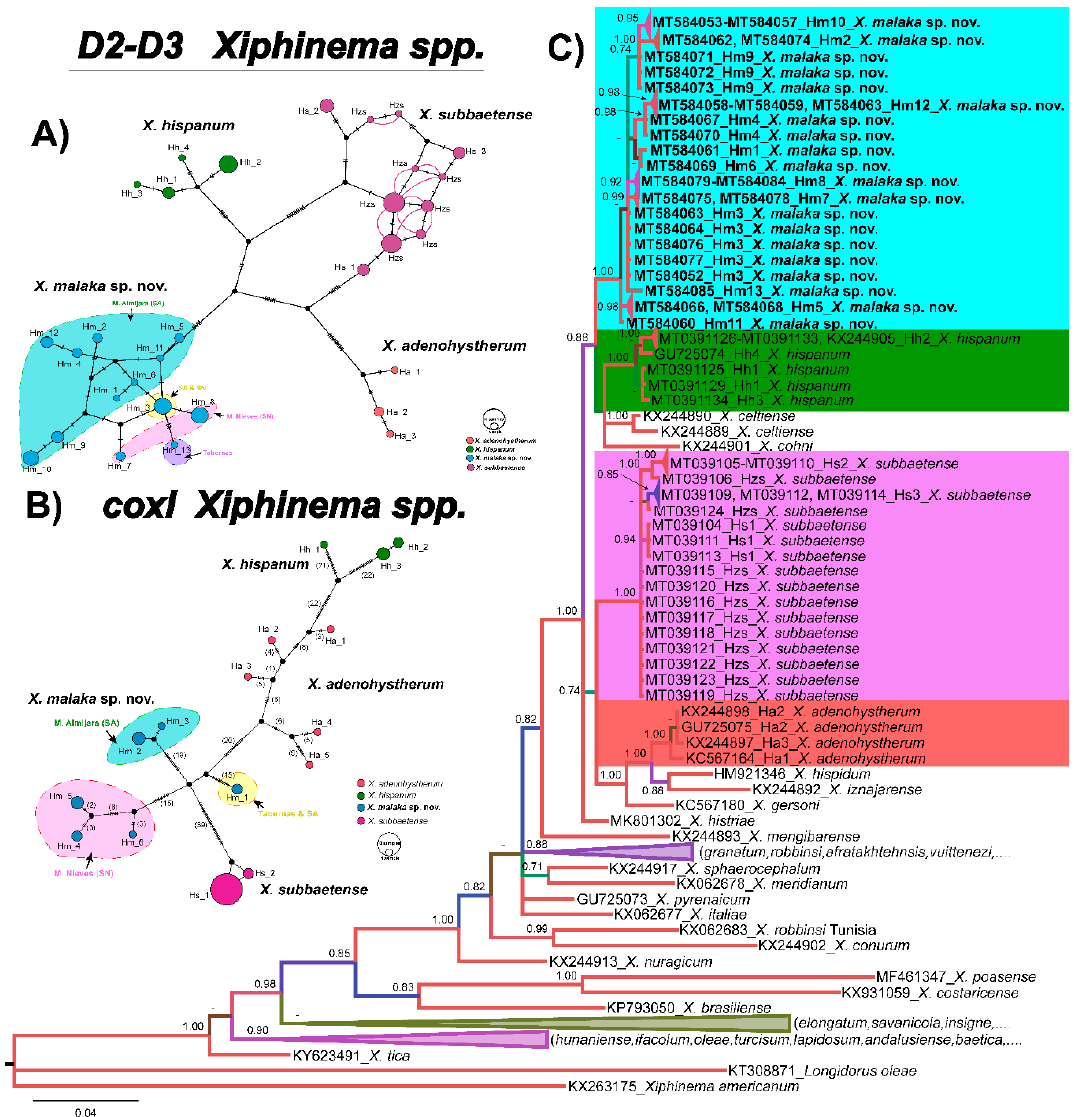
Figure 3. ( A ). Construction of D2-D3 haploweb of Xiphinema malaka sp. nov. ( B ). coxI haplonet of Xiphinema malaka sp. nov. Coloured circles represent haplotypes and their diameter are proportional to the number of individuals sharing the same haplotype. Black short lines on the branches indicate the number of mutated positions in the alignment that separate each haplotype. Co-occurring haplotypes are enclosed in black dashes. ( C ). Phylogenetic relationships within the genus Xiphinema . Bayesian 50% majority rule consensus tree as inferred from D2 and D3 expansion domains of 28S rRNA sequence alignment under the general time-reversible model of sequence evolution with correction for invariable sites and a gamma-shaped distribution (GTR + I + G) + . Posterior probabilities more than 0.70 are given for appropriate clades. Newly obtained sequences in this study are shown in bold. Scale bar = expected changes per site. Some branches were collapsed for improving readability of Xiphinema